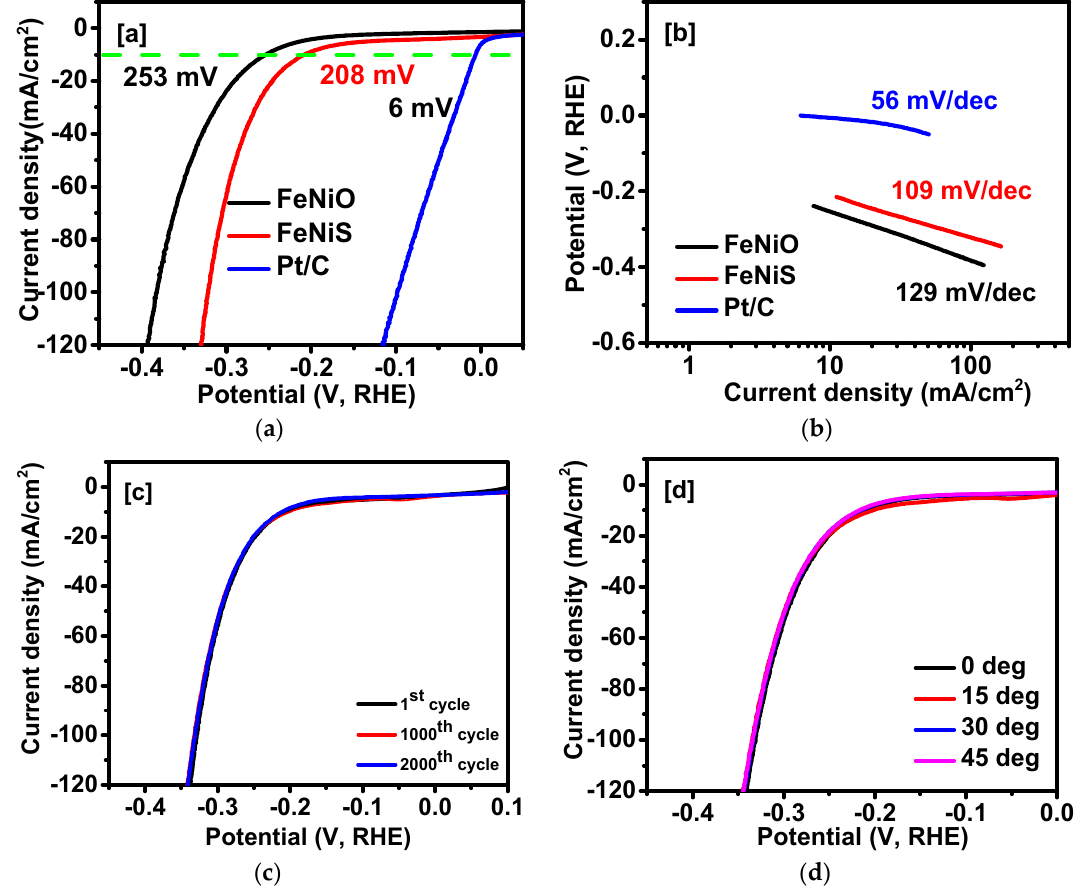
Figure 4. ( a , b ) Polarization curves and Tafel slopes for FeNiO, FeNiS and Pt/C in HER region, ( c ) LSV curves after different stability cycles and ( d ) LSV curves at different bending angles.